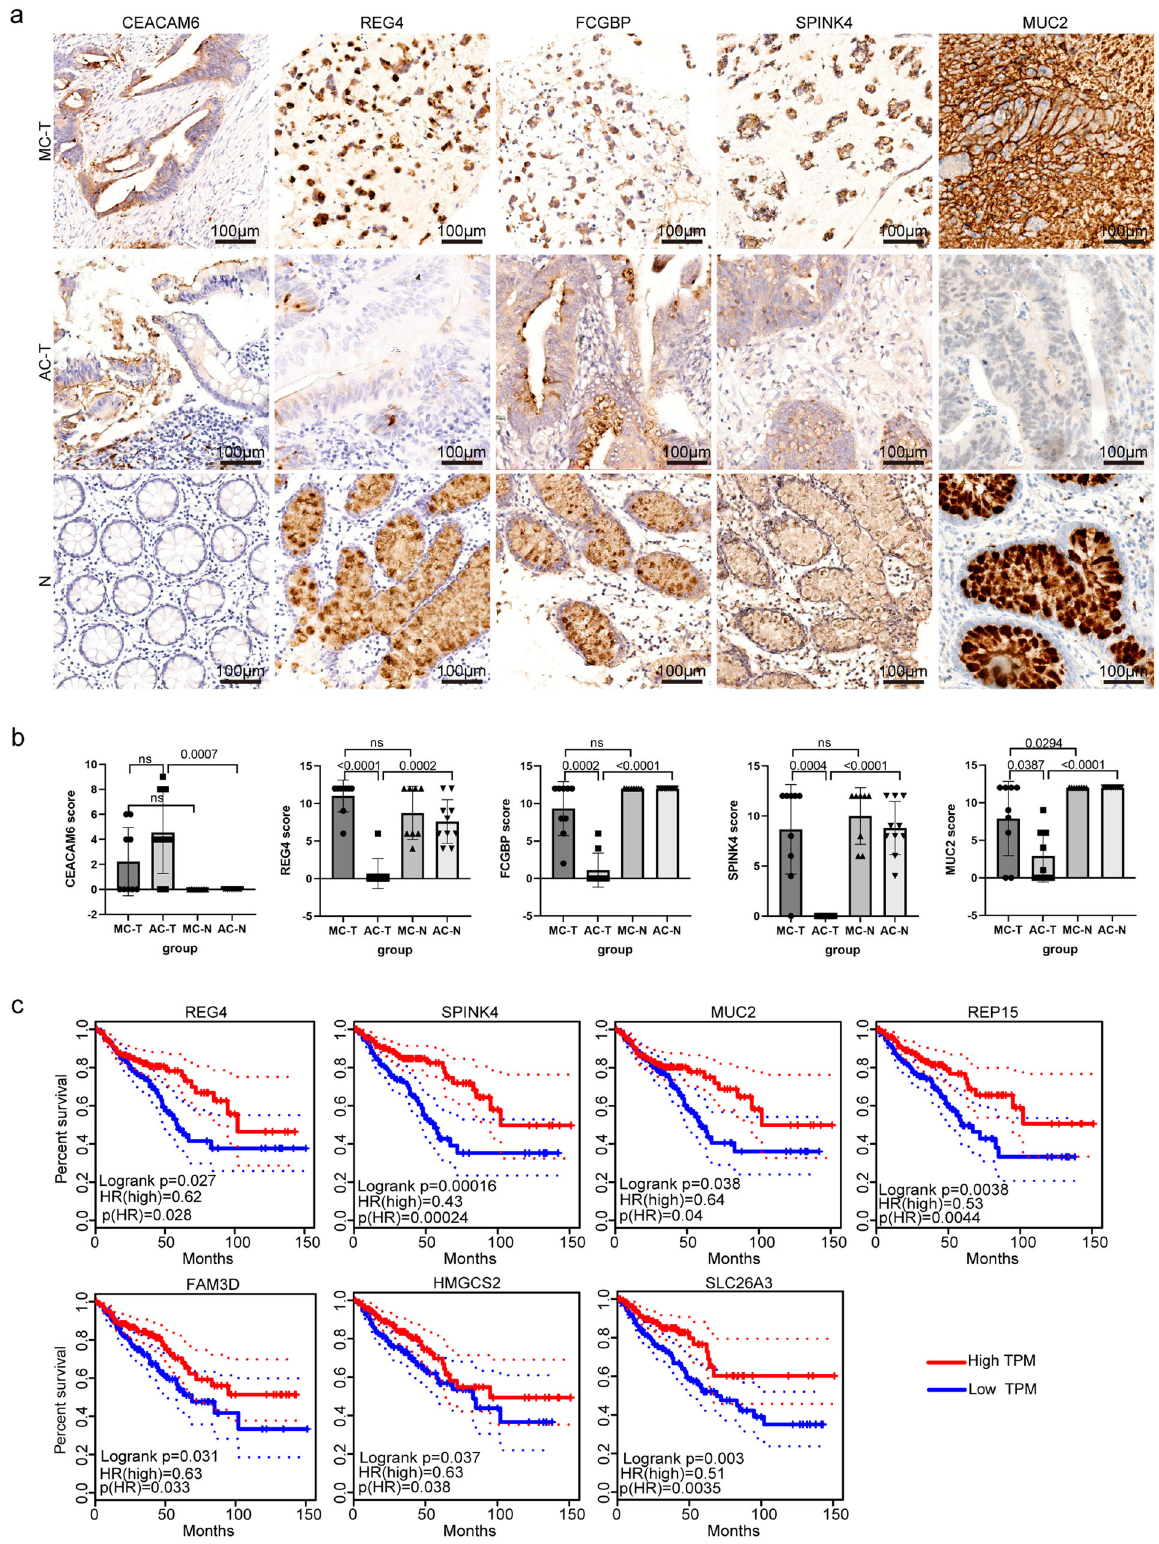
Fig. 5 IHC and survival analysis of MC markers. a Representative images of IHC staining of CEACAM6, REG4, FCGBP, SPINK4 and MUC2 expression in paired MC or AC cancer tissues and corresponding normal tissues. Scale bar, 100 μ m. b Differential analysis of CEACAM6, REG4, FCGBP, SPINK4 and MUC2 levels in paired MC cancer tissues and normal tissues ( n = 9 biologically independent patients) and AC cancer tissues and normal tissues ( n = 9 biologically independent patients). Statistical analyses were performed by a nonparametric test followed by the Mann ‒ Whitney test. All the bars represent the mean ± S.D. c Kaplan ‒ Meier survival curves were generated for the top 20 DEGs by comparing groups of high (red line) and low (blue line) gene expression. The dotted line represents the 95% con fi dence interval. p < 0.05 according to the log-rank